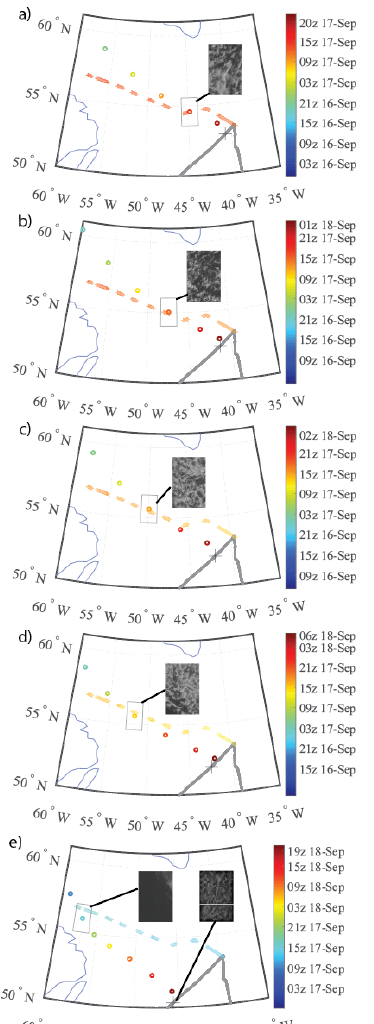
Figure 6. The location of FLEXPART back trajectories averaged over 6h intervals (shown as open circles) and low-level ( ∼ 0 . 1km) C130 surface measurements (shown as colored lines) are both col- ored as a function of time. The color bar range is different for each panel and is defined by the initialization time and end time of a 2d FLEXPART back trajectory initiated at the R/V Atlantis . The ini- tialization times for the back trajectories are (a) 23:00UTC on 17 September, (b) 02:00UTC on 18 September, (c) 05:00UTC on 18 September, (d) 07:00UTC on 18 September, and (e) 21:00UTC on 18 September. The gray line represents the R/V Atlantis ship track, and the black cross on the ship track in panels (a) – (e) represents the location of the R/V Atlantis for the initialized back trajectory. The black rectangles around individual FLEXPART back trajectory intervals show the 2 ◦ × 2 ◦ area in which C130 measurements were averaged and compared to downwind particle measurements (Ta- ble 3). The GOES-East satellite visible image for the 2 ◦ × 2 ◦ area is included to present the cloud coverage corresponding to the time of the averaged 6h back trajectory interval. The GOES-East visi- ble satellite image of the 2 ◦ × 2 ◦ area around the ship initialization point in panel (e) is also included. Other trajectories were initialized at night and have no corresponding visible image.